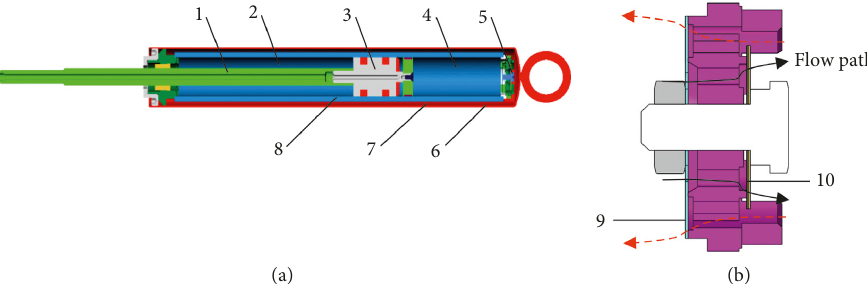
Figure 3: (a) Section view of a twin-tube MR damper. (b) Details of foot valve.1, piston rod; 2, rebound chamber; 3, piston; 4, compression chamber; 5, foot valve assembly; 6, outer housing; 7, MR fluid reservoir; 8, inner housing; 9, return valve; 10, compression valve [2].